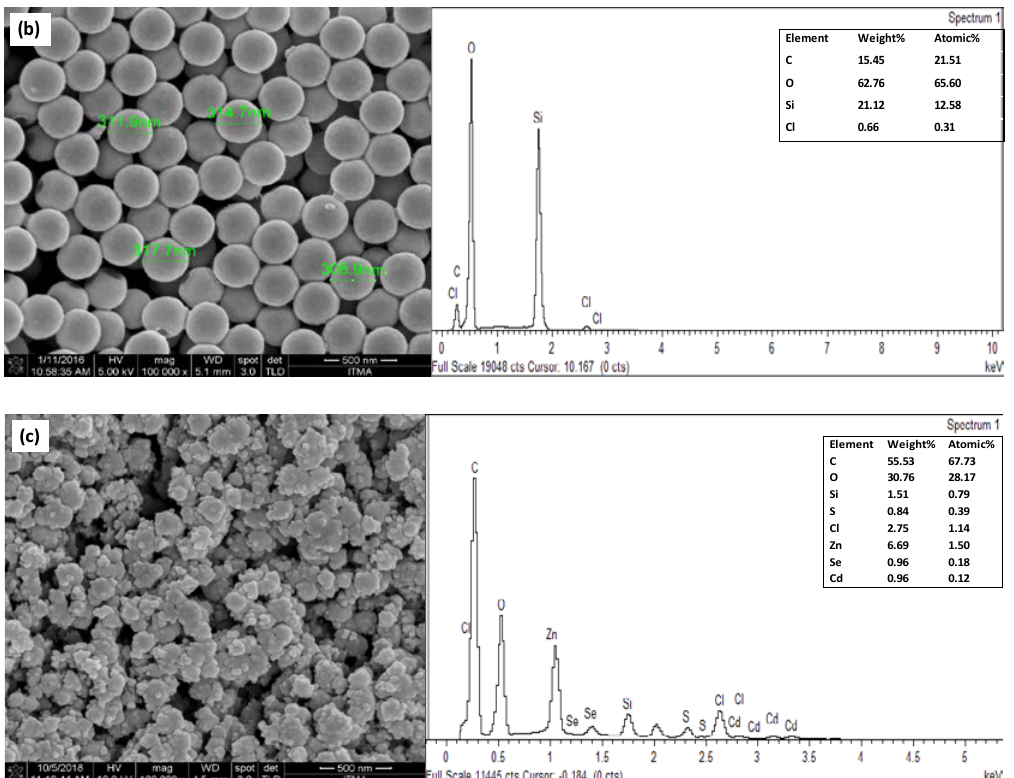
Figure 3. Images of field emission scanning electron microscopy (FESEM) under 100 k magnification and EDX of ( a ) bare screen-printed carbon electrode (SPCE), ( b ) SiNPs/SPCE, and ( c ) CdSe/ZnS QD/SiNPs/SPCE.